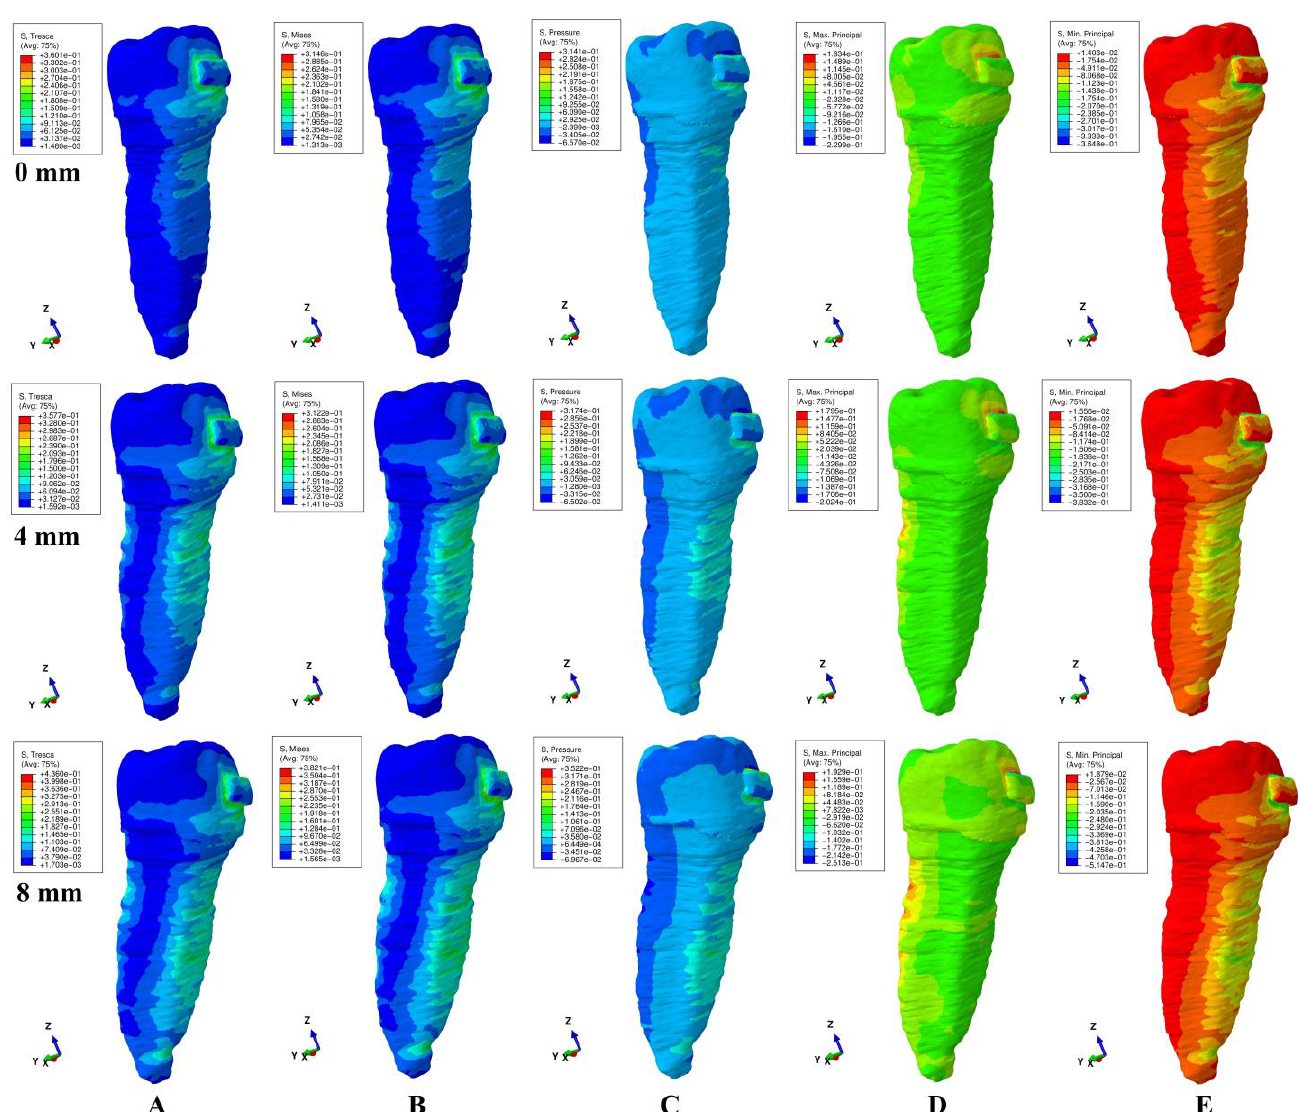
Figure 4. Comparative stress display of the five failure criteria in intact, 4 mm and 8 mm periodontal breakdown for the intrusion movement under 0.5 N of load: ( A ) Tresca; ( B ) Von Mises; ( C ) Pressure; ( D ) S1; ( E ) S3.